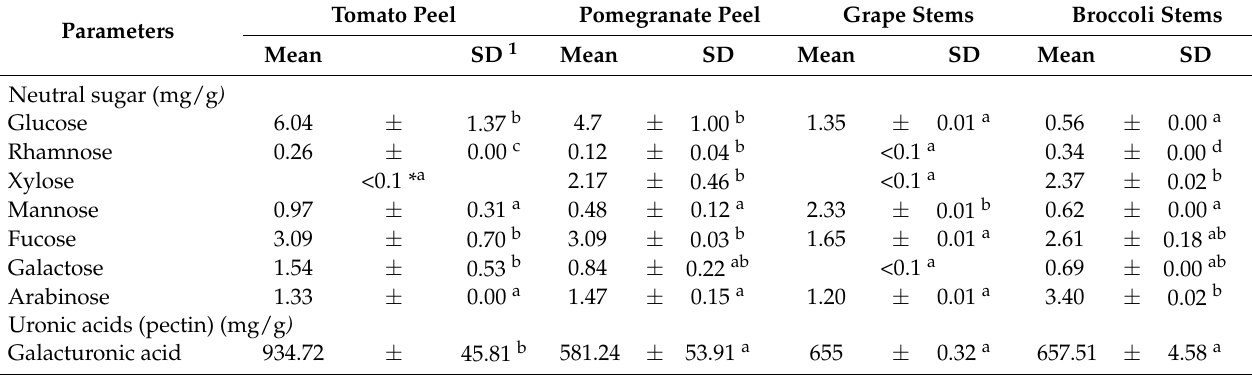
Table 1. Neutral sugar and uronic acid profile of dietary fibre from vegetable by-products (mg/g dry weight).